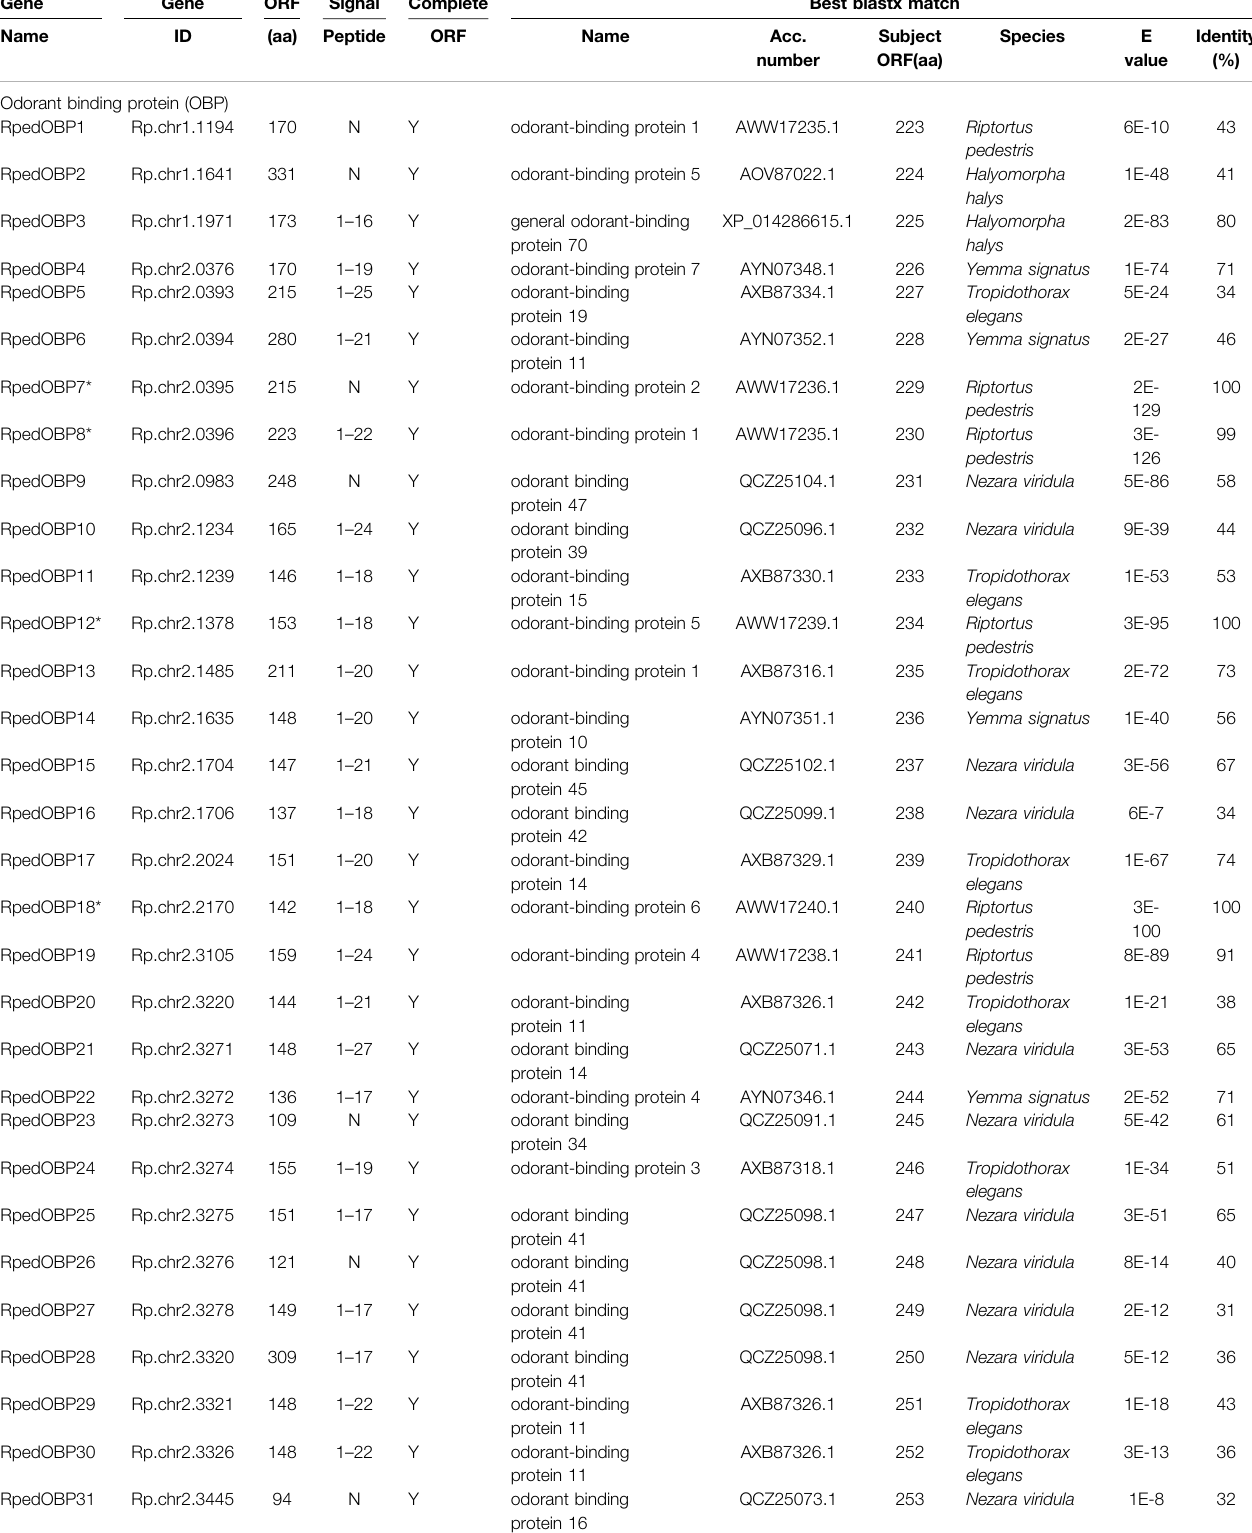
TABLE 1 | The sequences information of RpedOBPs and